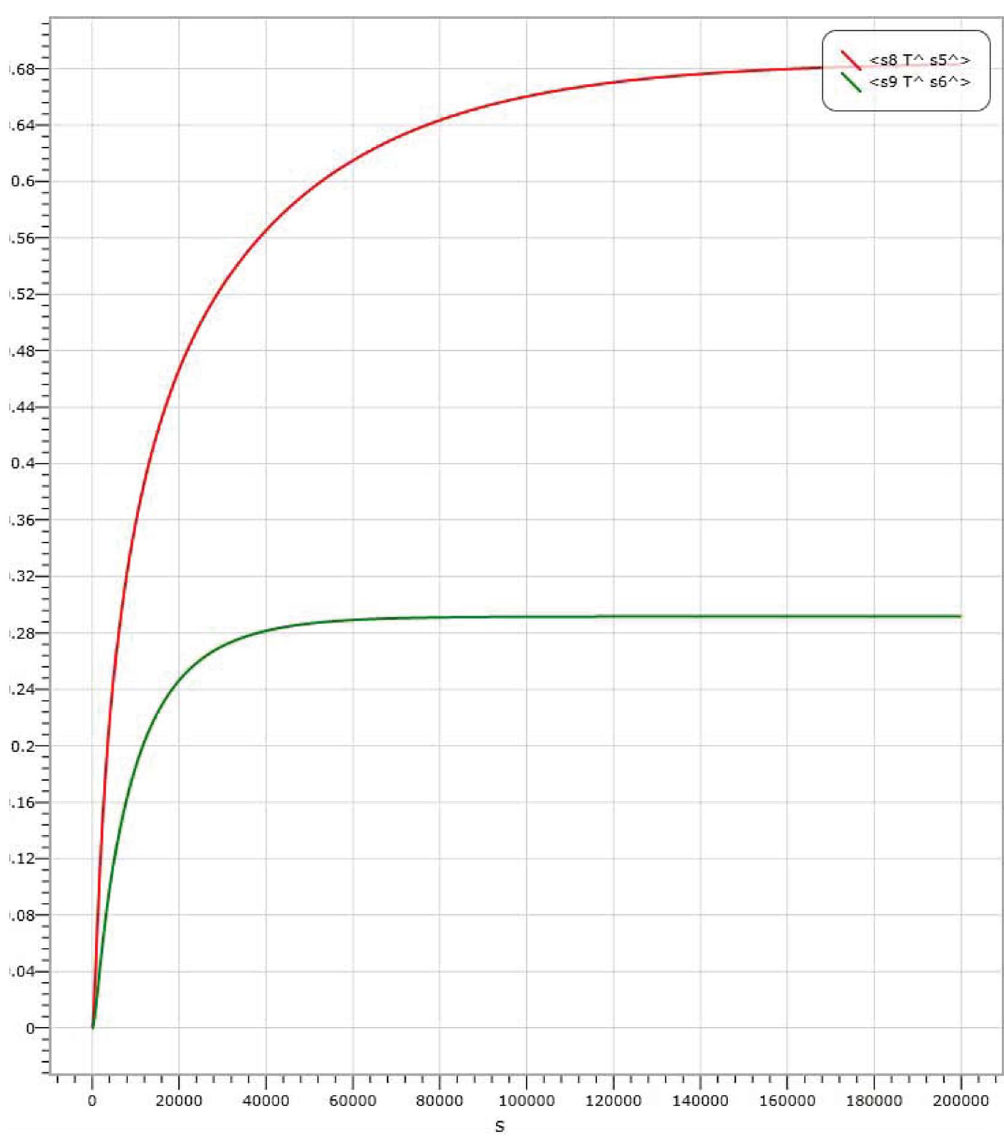
Figure 10. Visual DSD simulations of XOR logic gate with input signal ‘‘01’’.